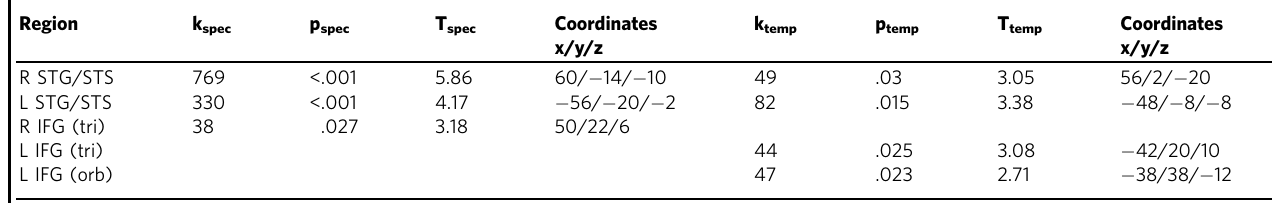
Table 1 Clusters of activation during speaking with spectrally (columns two to fi ve) or temporally altered feedback (columns six to nine) compared to normal speaking (conjunction over consonant and vowel perturbations), small volume corrected for multiple comparison in literature-based ROIs at p < 0.05 with a cluster de fi ning threshold of p < 0.001 (one-sided, paired t -test, n = 22 participants).